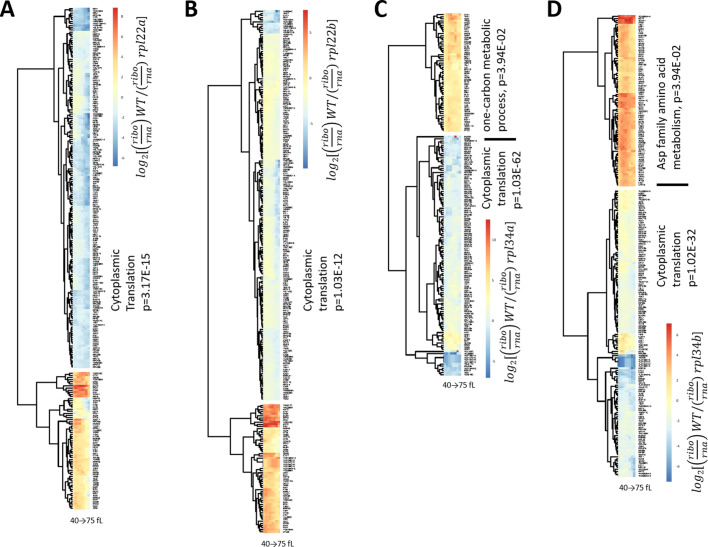
Dysregulation of the translational efficiency of transcripts encoding gene products involved in cytoplasmic translation in cells lacking Rpl22 or Rpl34 paralogs.Heatmaps of the transcripts with significantly different translational efficiencies (see Figure 2) between wild type diploid cells (from Blank et al., 2017) and rpl22aΔ/rpl22aΔ (A), rpl22bΔ/rpl22bΔ (B), rpl34aΔ/rpl34aΔ (C), rpl34bΔ/rpl34bΔ (D) cells. The ratio of the TPM values for the ribosome footprints ((ribo) against the corresponding values for the mRNA reads (rna) define the translational efficiency of each locus in each strain. The data were hierarchically clustered and displayed with the pheatmap R package. Each column corresponds to a separate cell size interval, from 40 to 75 fL, from left to right. The Gene Ontology terms highlighted were enriched, based on the PANTHER platform classification, incorporating the Holm-Bonferroni correction. mRNAs with missing values across the cell sizes we analyzed were not included in the heatmaps. All the gene names of loci with significant changes in translational efficiency are also in Figure 5—source data 1 (sheet ‘cumulative’).